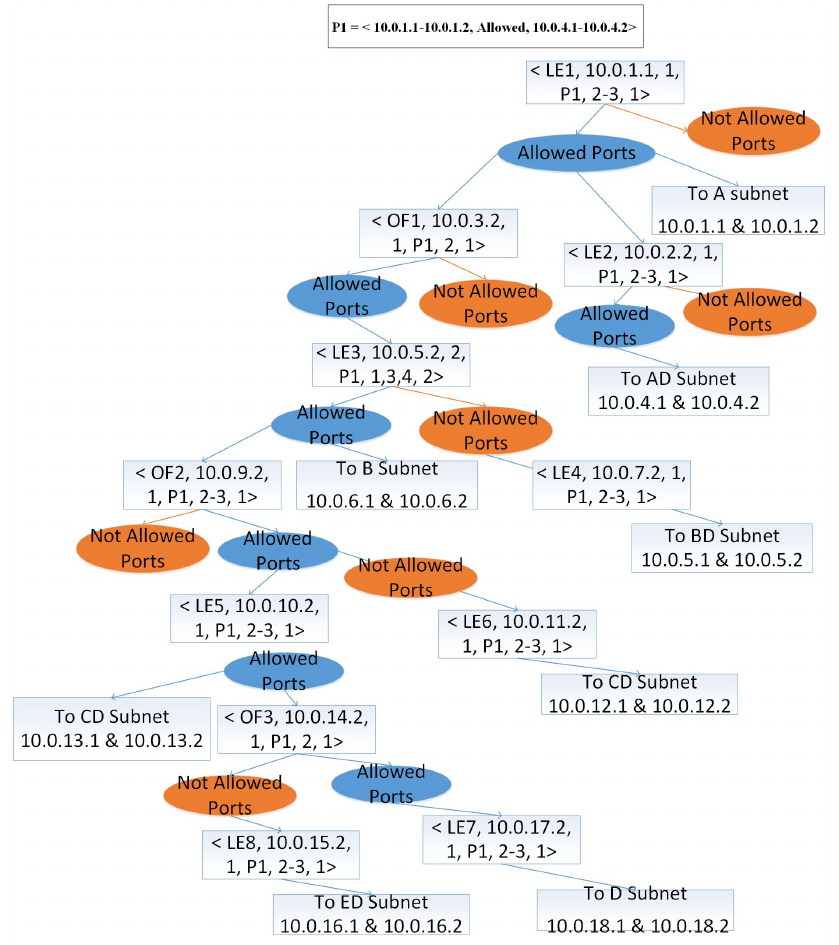
Figure 7. Graph traversing for policy